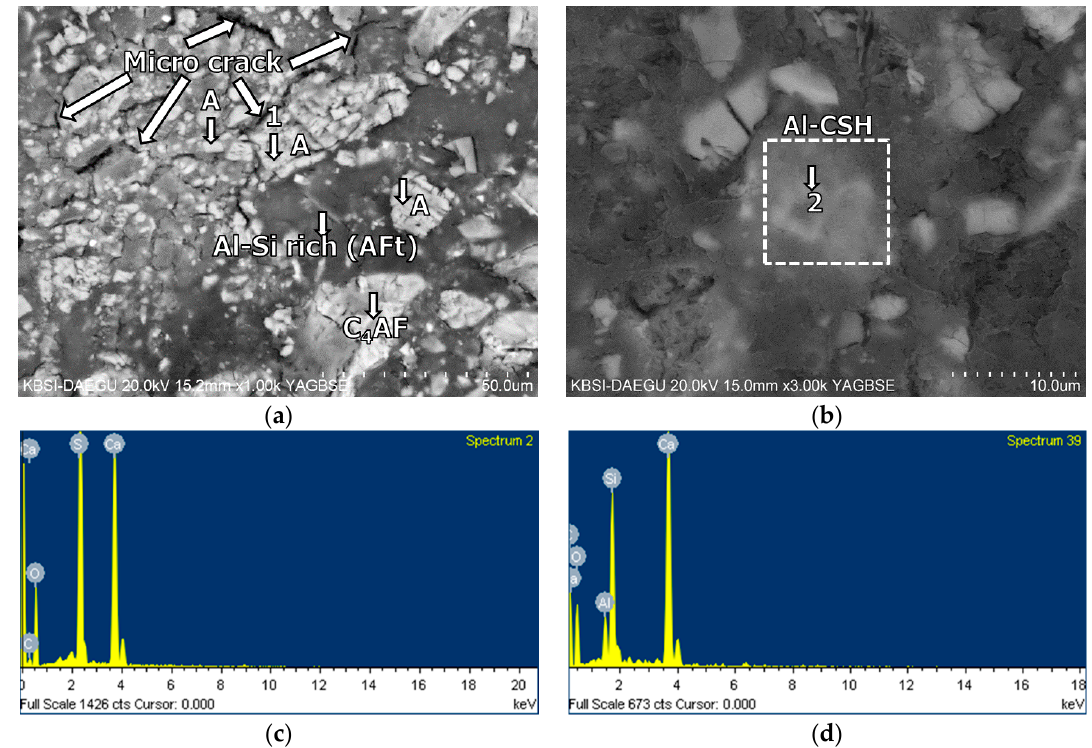
Figure 10. The Al/Ca vs. Si/Ca ratios for Mixtures ( a ) B-0-N and B-0-Y; and ( b ) B-10-Y at different ages.